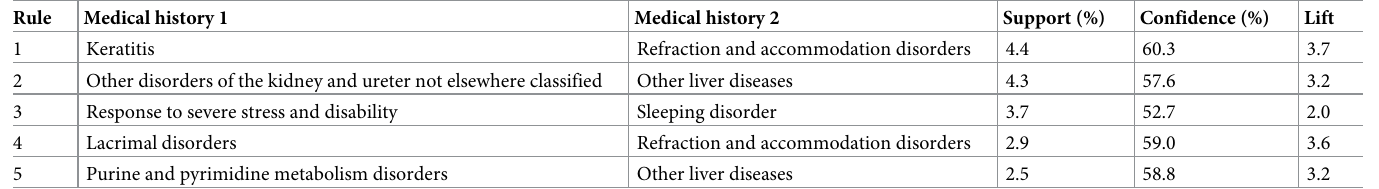
Table 3. Association rules of complications after the onset of depression for patients with X = other causes of gastroenteritis and colitis, infections, and unknown causes and Y = gastritis and duodenal inflammation. Rule Medical history